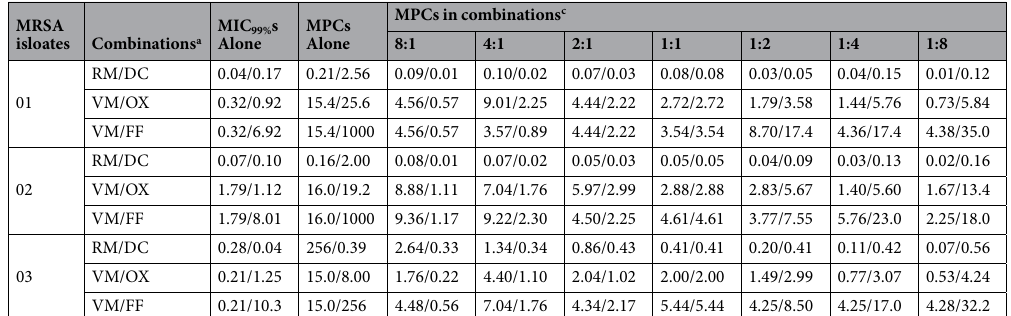
Table 2. MIC 99% s and MPCs of antimicrobial agents alone and their MPCs in combinations a . a Most data were published as an abstract of oral presentation at ISAAR&ICIC 2017 42 . b RM: roxithromycin, DC: doxycycline, VM: vancomycin, FF: fosfomycin, OX: ofloxacin. c MPCs of two antimicrobial agents in three combinations with seven different